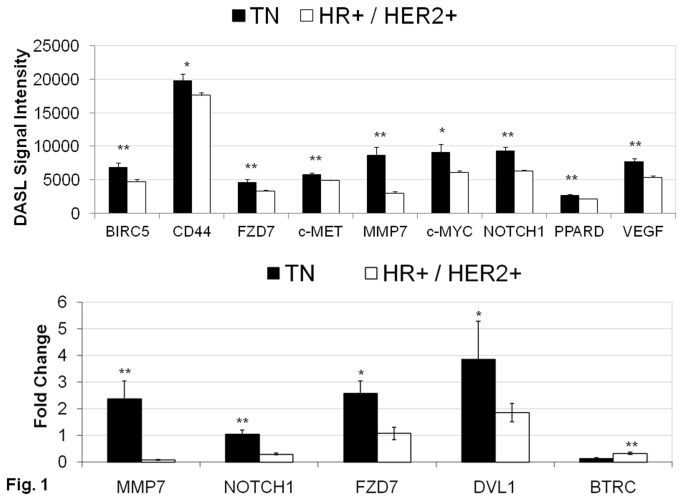
Expression of mRNA for a number of different components of Wnt-β-catenin pathway (WP) and transcriptional targets of WP in Triple Negative subset of Breast Cancer (TNBC) patients.Figure shows the expression of mRNAs for different components of Wnt-signaling in the Montreal cohort (upper panel). Average DASL signal intensity of Wnt transcriptional targets in Triple Negative (TN) tumors (black) are compared to non-TN (HR+ and HER2+) tumors (white). p-values < 0.05 determined using a t-test for unequal variances and Bonferroni’s correction for 46 Wnt related genes on a custom breast cancer DASL panel used to study the expression profile of the Montreal cohort (upper panel). RT-PCR confirmation of Wnt-signaling components in the Montreal cohort is shown (lower panel). Wnt transcriptional targets were validated using RT-PCR (10 TN and 10 HR+ patients in the Montreal cohort). The Wnt transducer DVL1 and the Wnt agonist BTRC were analyzed by RT-PCR and both increased (indicative of an increased Wnt signaling) in TN tumors. Asterisks (*) indicate p-values < 0.01 of differential regulation using two-sided t-tests for unequal variances and Bonferroni’s correction for multiple hypothesis (lower panel).